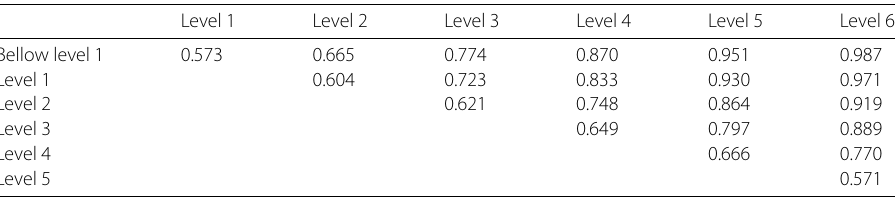
Table 2 Model performance in discrimination between different proficiency levels measured as the area under the ROC